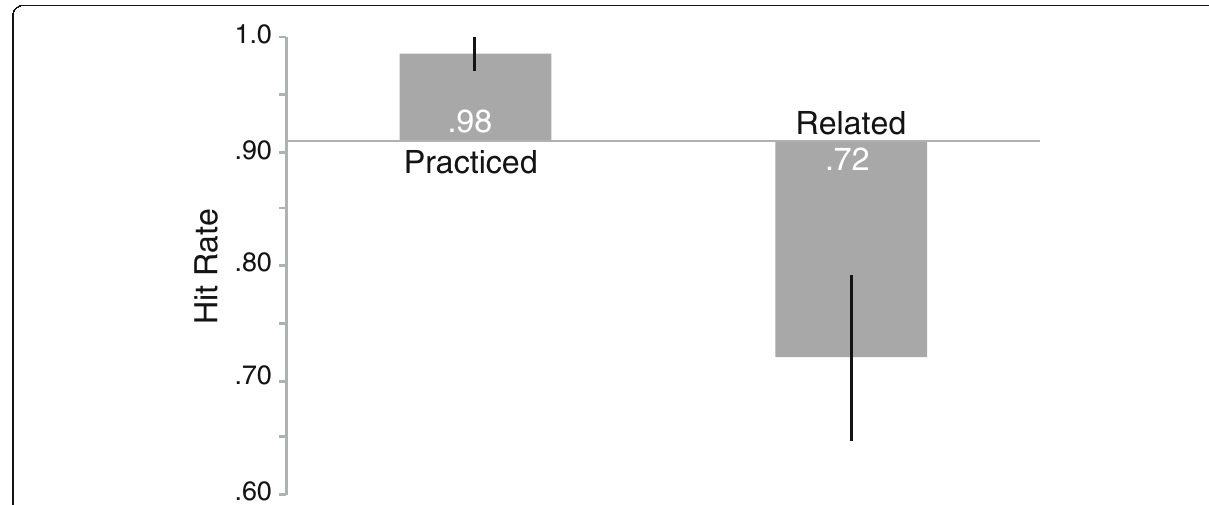
Fig. 4 Hit rate for old objects in the test phase by object type from Experiment 3. The x axis represents memory for baseline objects and error bars represent 95% confidence intervals as described by Cousineau (2005) with Morey ’ s correction applied (Morey,